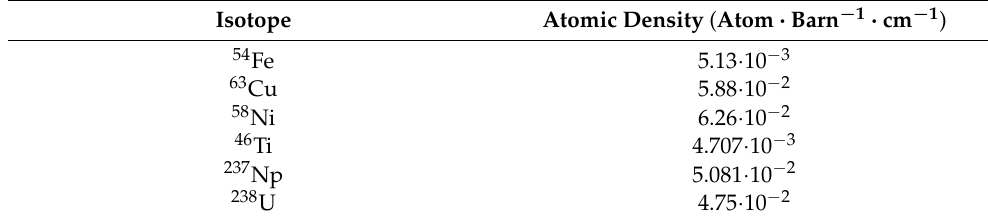
Table 3. Dosimeter composition as defined in the “HBRHE81” input file